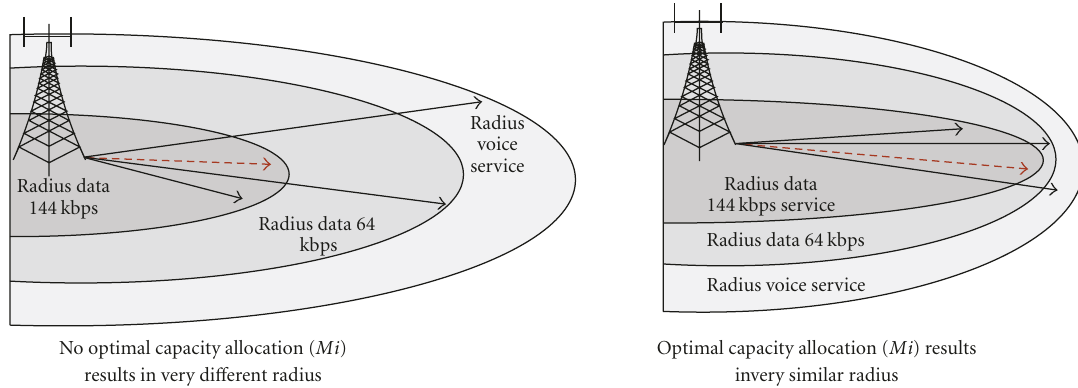
Figure 4: Scheme of the cell radius with optimal and no optimal capacity